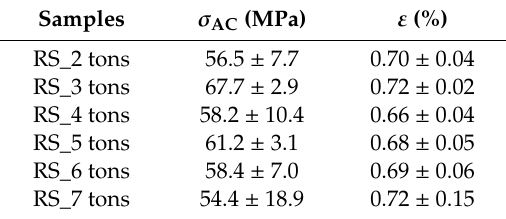
Table 4. Averaged results of axial compression tests for RS pellets at lab